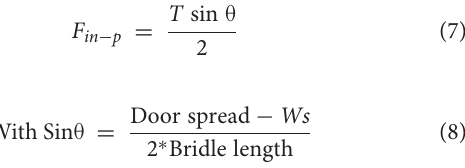
Frontiers in Marine Science |